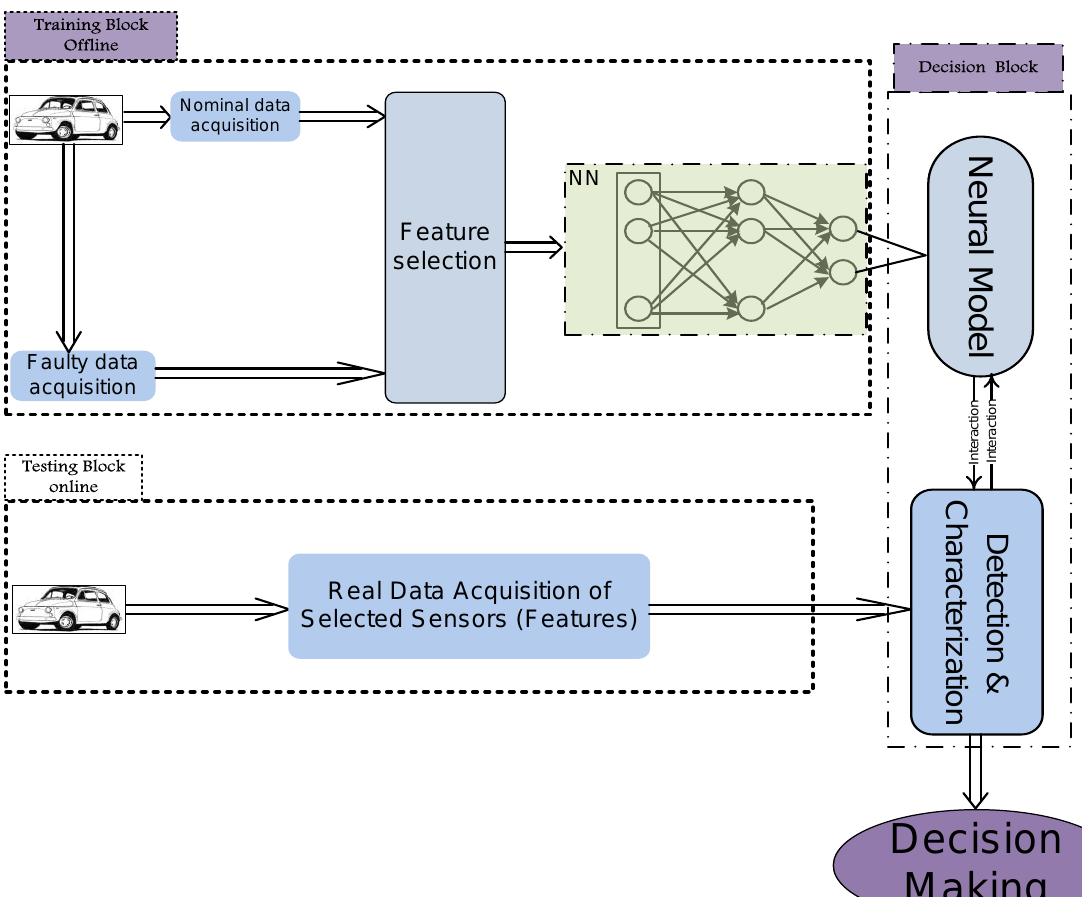
Figure 1. Detection and characterization